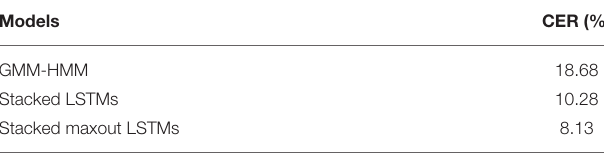
TABLE 1 | Details of the predefined guidance opinions. TABLE 2 | CER values of different models for speech